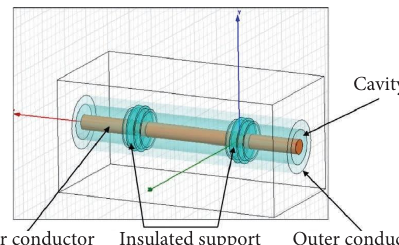
Figure 3: Basic model of the 65GHz · millimeter-wave